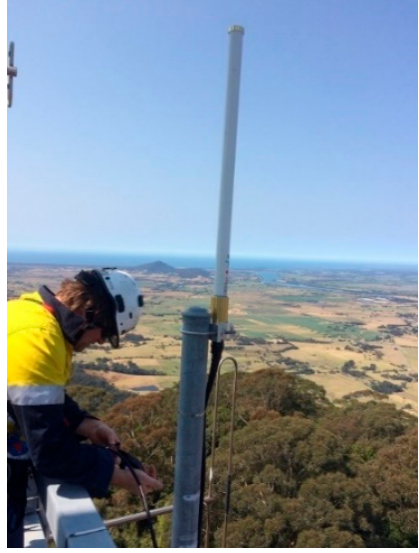
Figure 18. Omnidirectional antenna placement.